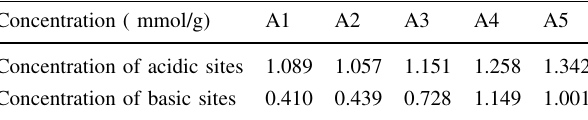
Fig. 3 High resolution of C1s spectrum of the